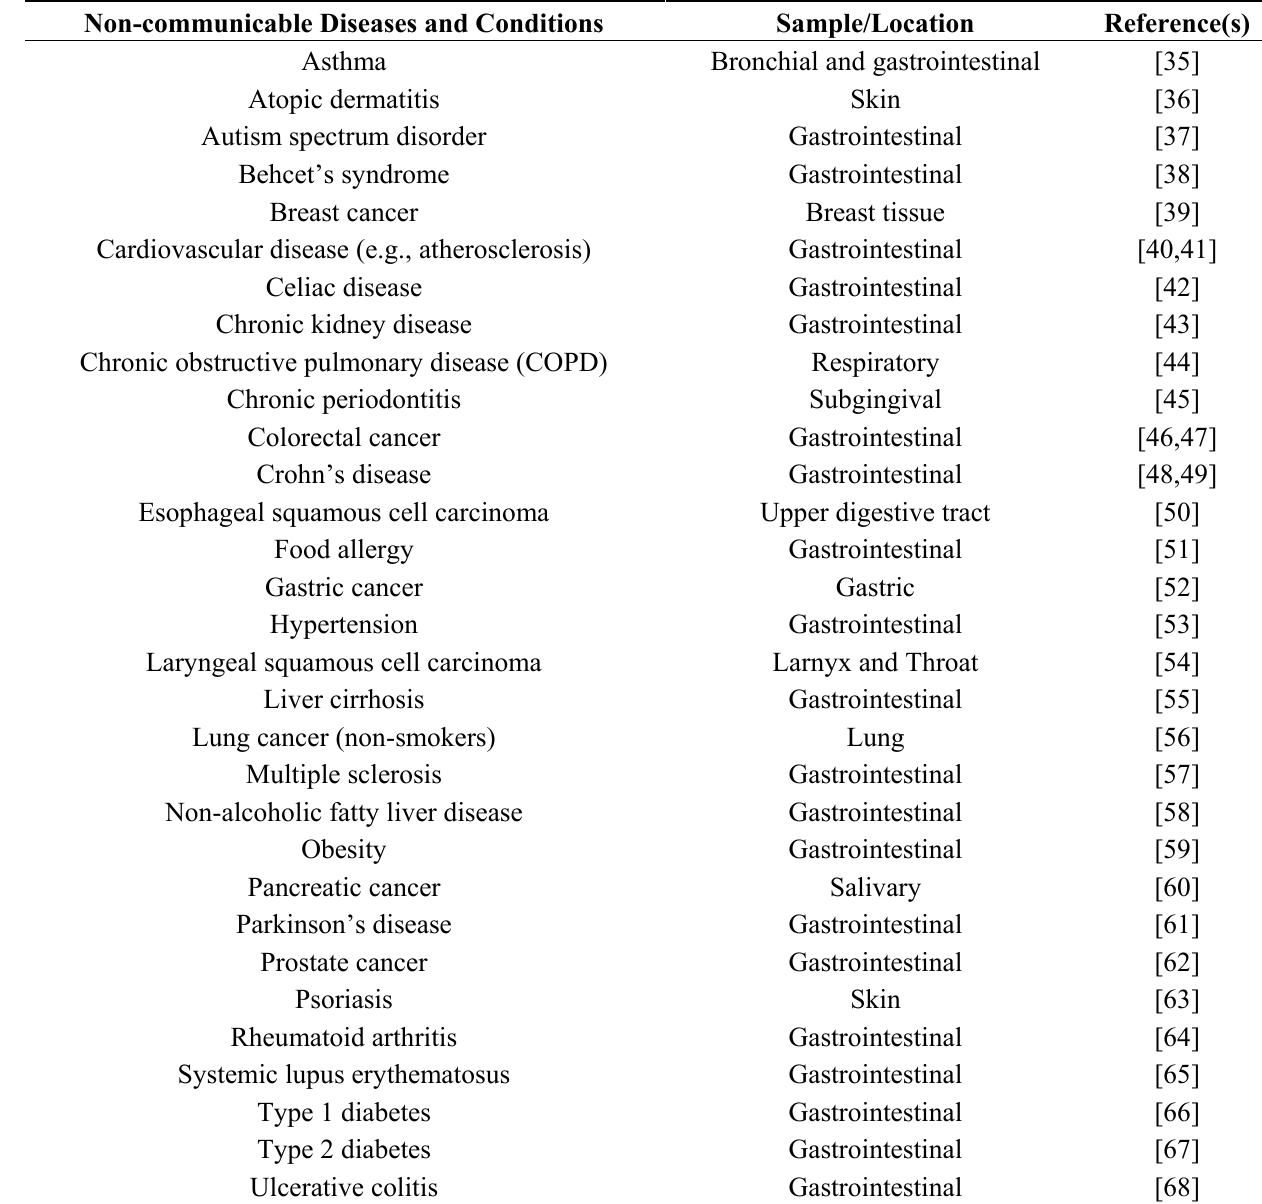
Table 1. Microbial dysbiosis and non-communicable diseases and conditions